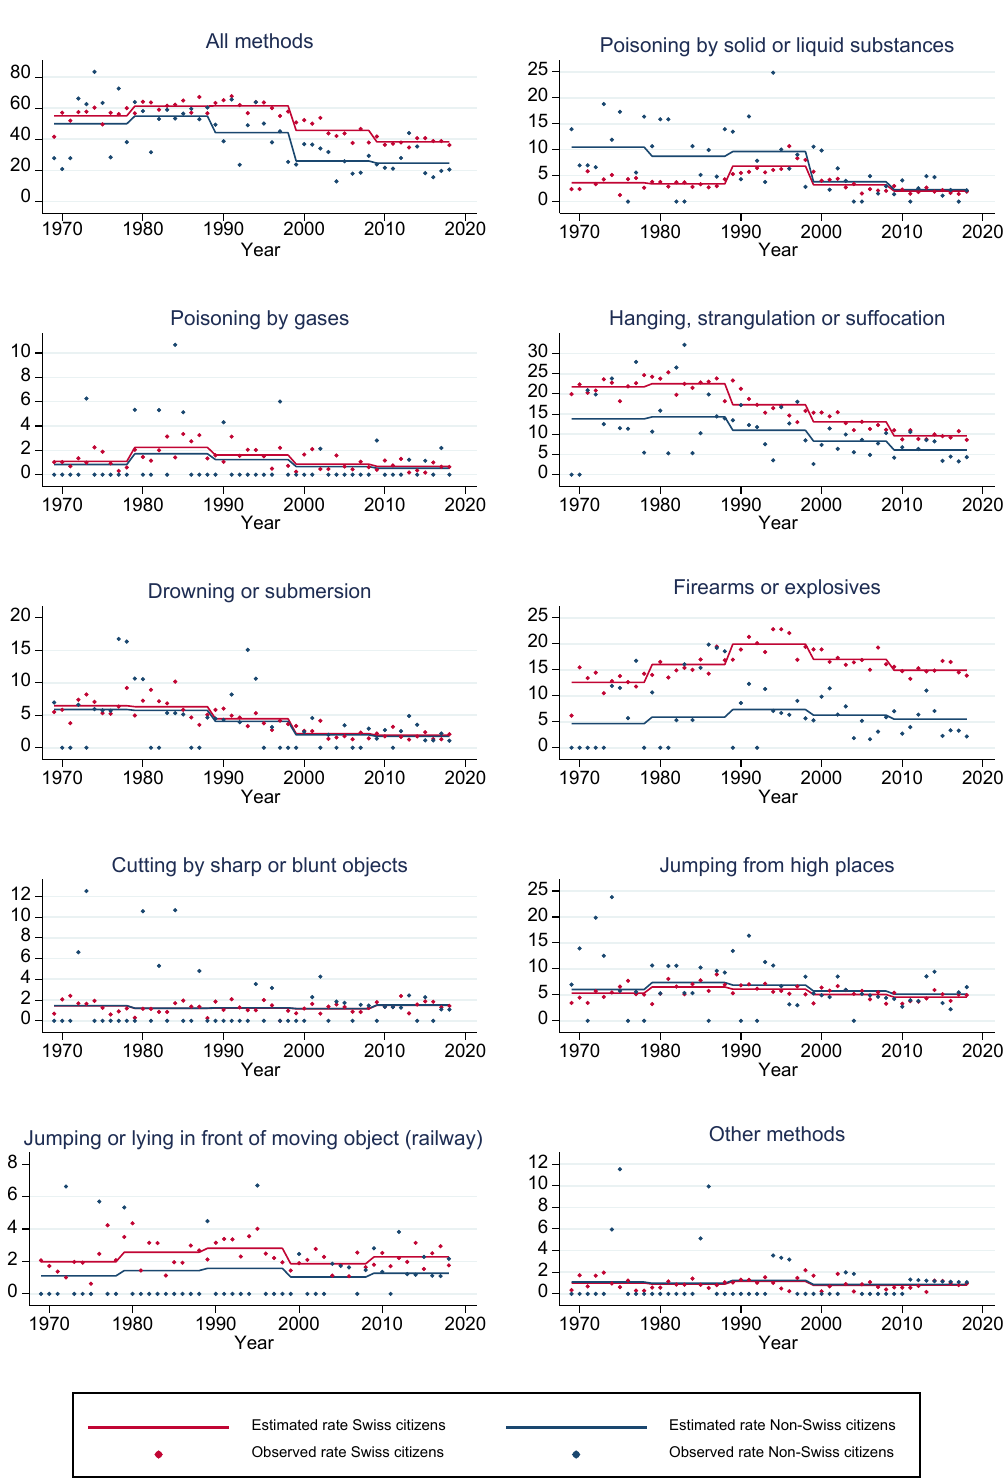
Figure S7. Rates of suicide methods per 100'000 population (person-years) in 65 or more years old men.